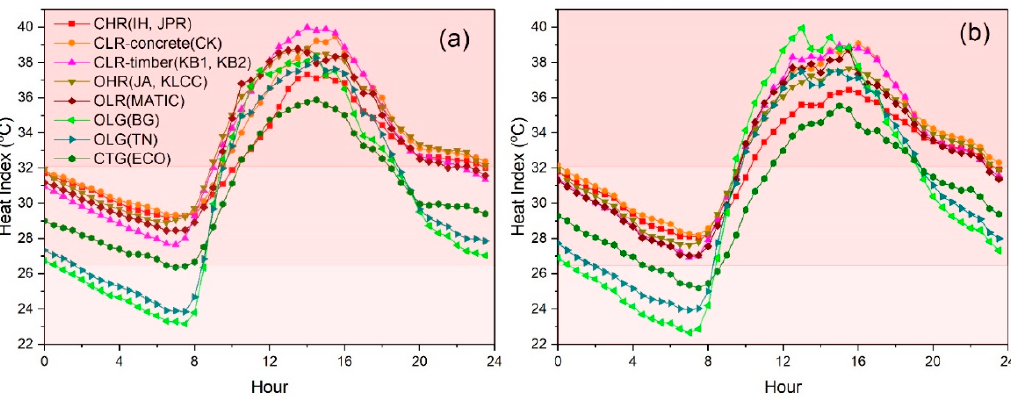
Figure 6. Diurnal variation of calculated heat index in wet ( a ) and dry ( b ) seasons for different land use areas.